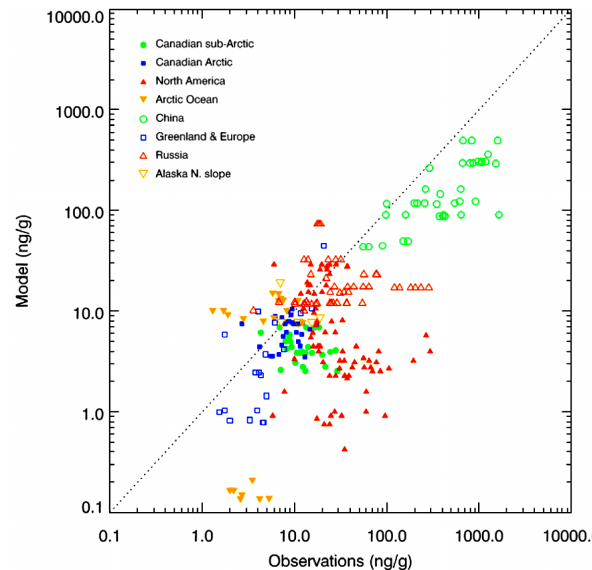
Figure 3. Comparison of measured and modelled BC in snow in log-scale scatter plot. The measurements are vertically averaged over depth for the top 25cm and compared to simulated results over the same grid box and